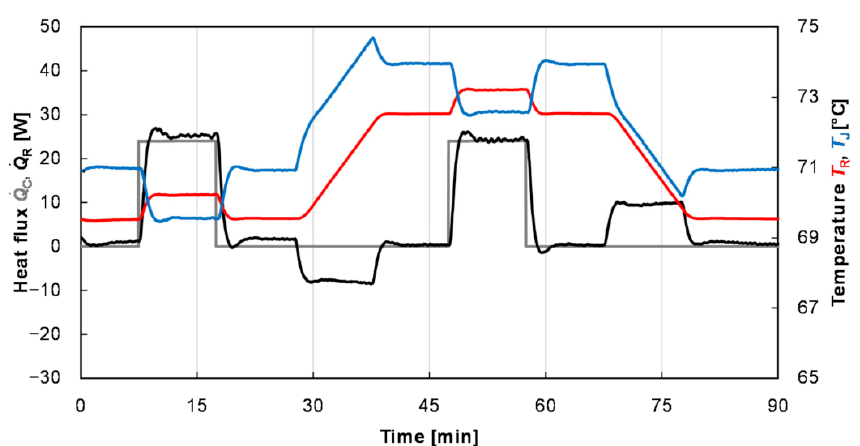
Figure 1. Automatic RC1e calibration for the determination of the heat passage term UA and the heat capacity c p of the reactor content. This is an example of the calibration before the reaction of 150 g/L acrylic acid in isopropanol at a reaction temperature of 70 ◦ C. The left axis shows the heat flow of the calibration ( Q C ) and the reaction ( Q R ), the right axis the reactor temperature ( T R ) and the jacket temperature ( T J